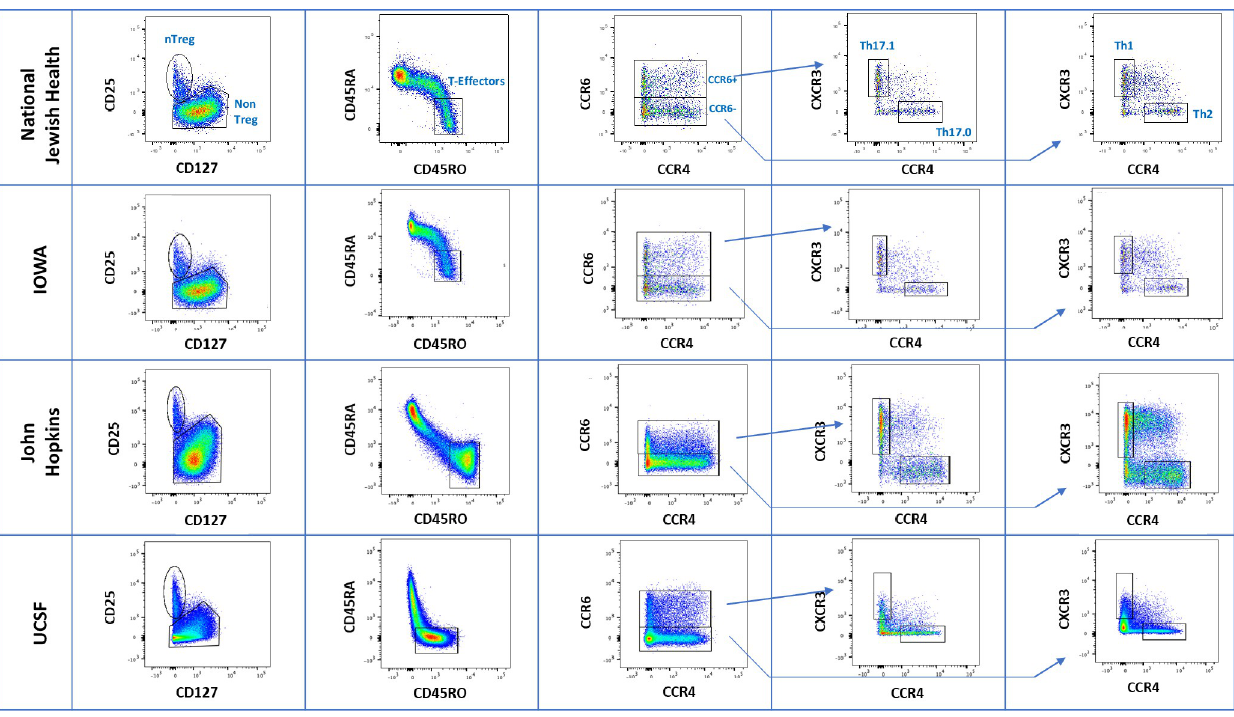
Fig 4. Comparison of human PBMC sample analysis between institutions after standardization. PBMCs from different human subjects were isolated, stained, and run on the flow cytometer at each study site. Shown are cell populations after gating on singlets, live/dead, lymphocytes each by FSC/SSC, and CD3+ cells. T cell subsets identified by the analysis include T effector, Th17.1, Th17, Th1, and Treg.